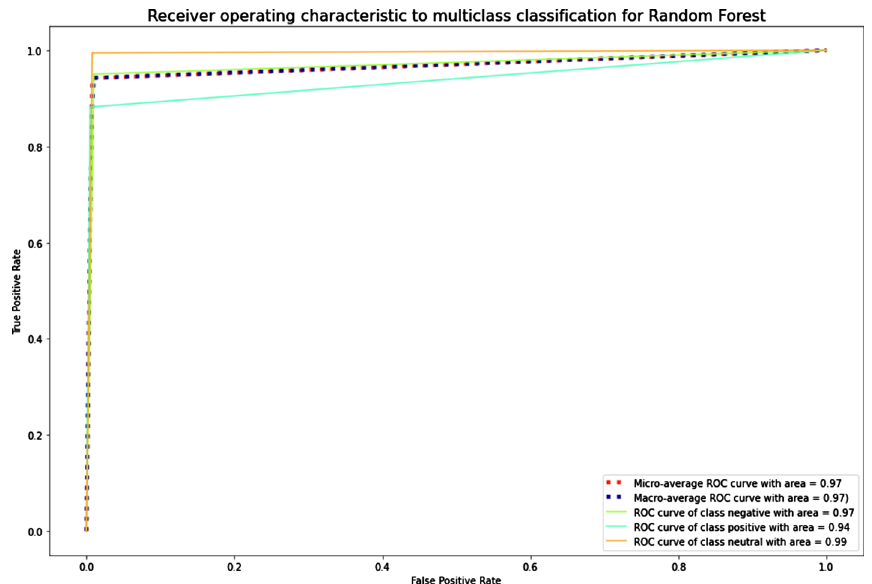
Fig. 19 A ROC curve for Kazakh texts of an RF algorithm